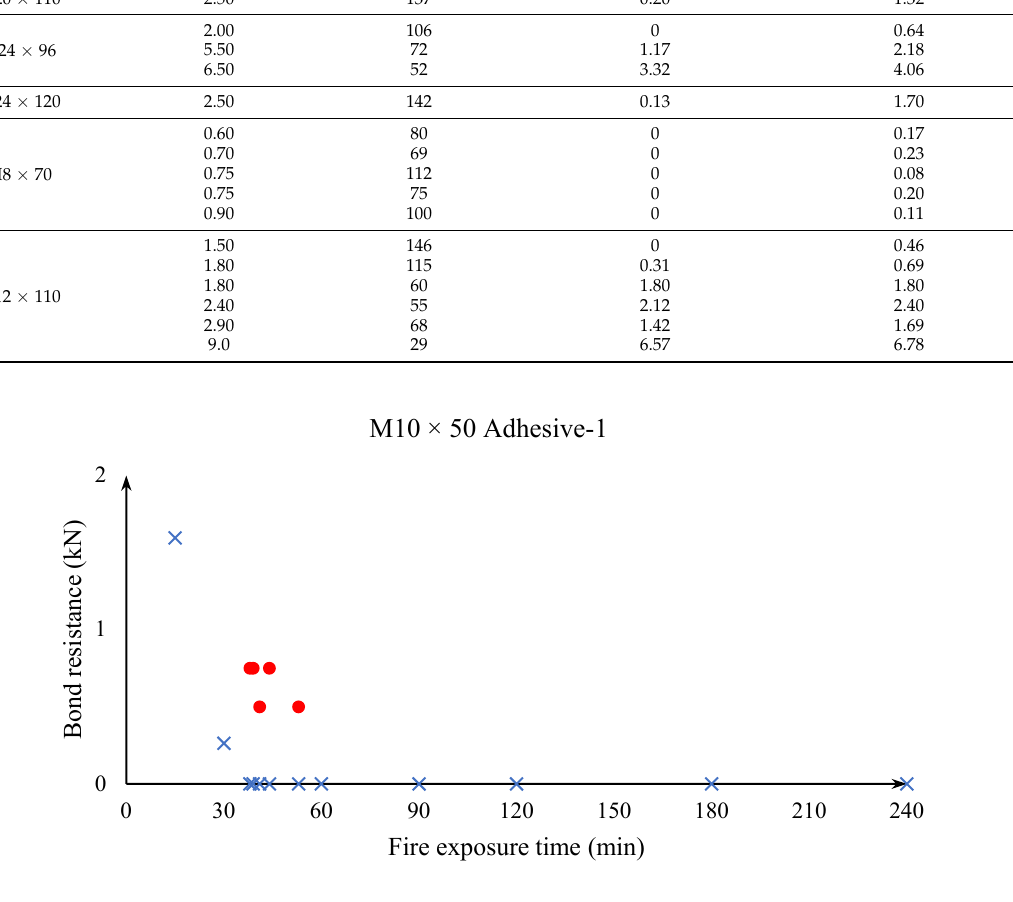
Figure 12. Fire resistance of M12 × 70 bonded anchor using Adhesive-2.